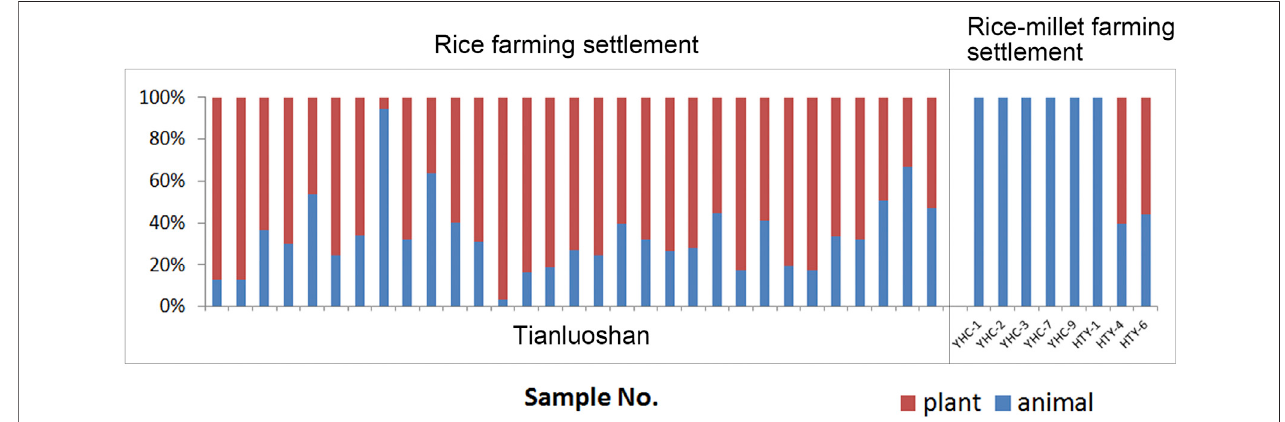
FIGURE 2 | Proportions of plant- and animal-derived sterols in coprolites recovered from rice farming settlement and mixed farming settlements.